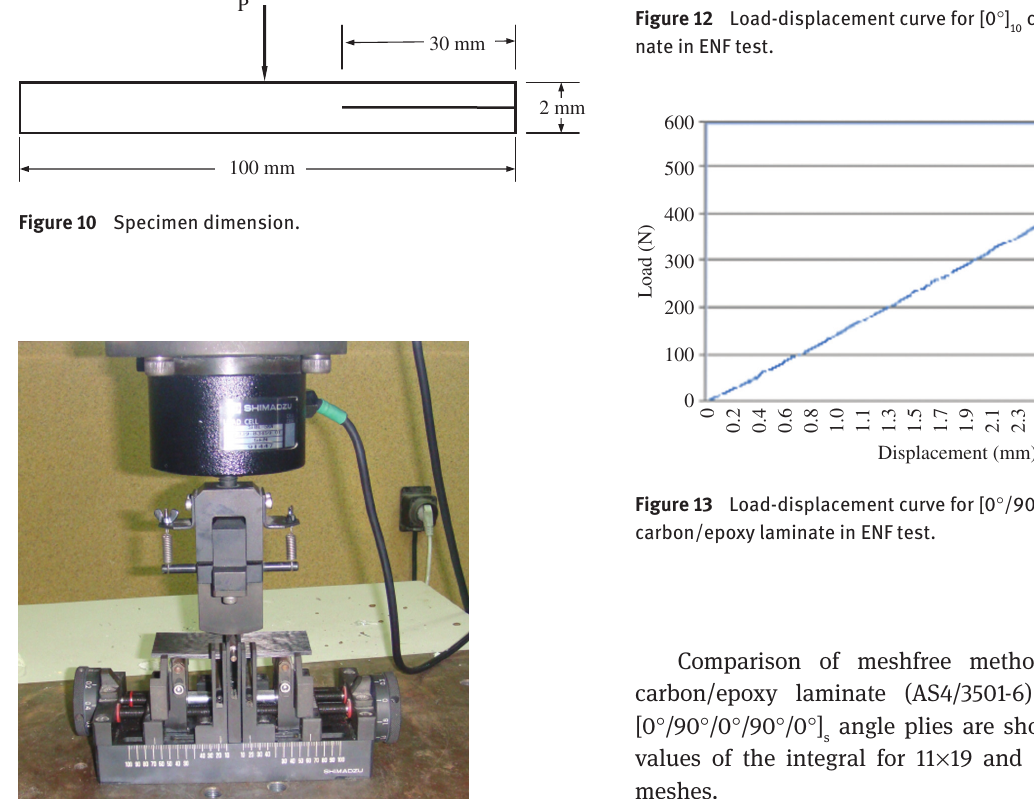
carbon/epoxy lami- 10